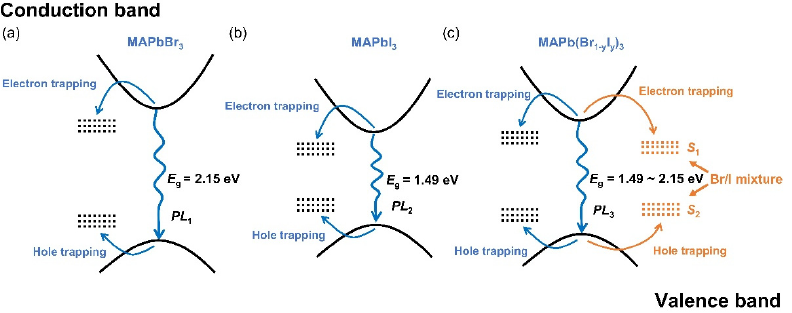
Figure 5. Schematic of carrier recombination dynamics in ( a ) MAPbBr 3 , ( b ) MAPbI 3 , and ( c ) MAPb(Br 1 − y I y ) 3